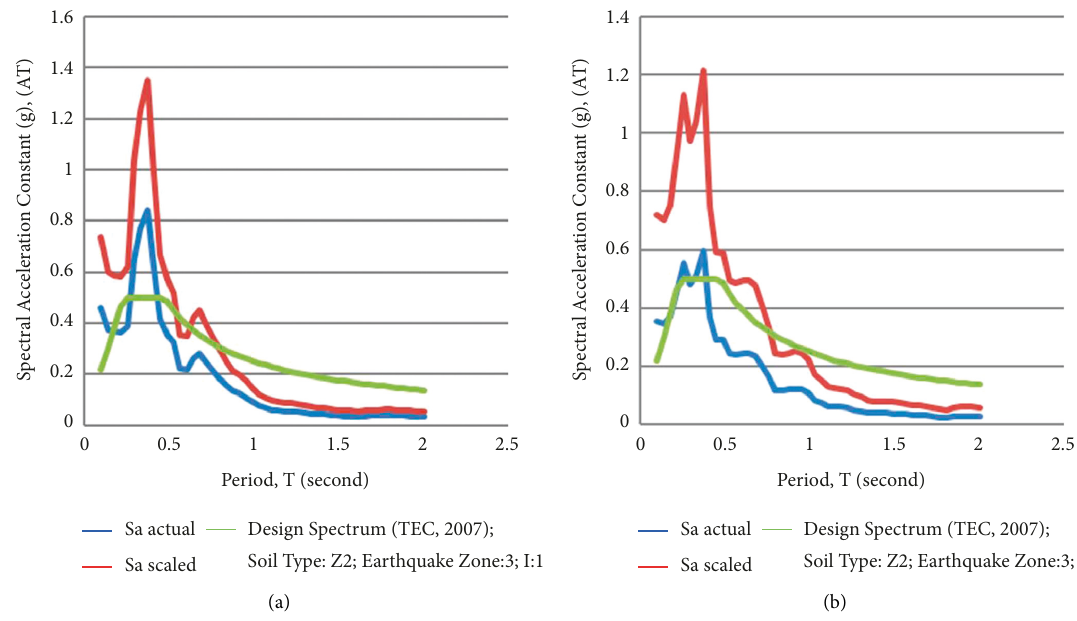
Figure 25: Evaluation of A(T) spectral acceleration constants for (a) North-South (N-S) and (b) East-West (E-W) components of earthquake with epicenter at Kayseri-Kocasinan ( M W :